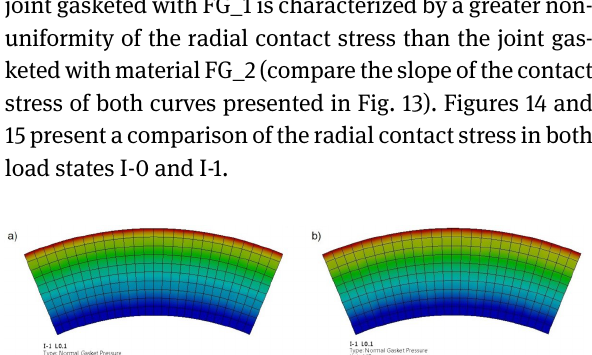
Figure 13: The radial contact stress along the gasket width in case of joint load corresponding to tightness L0.1